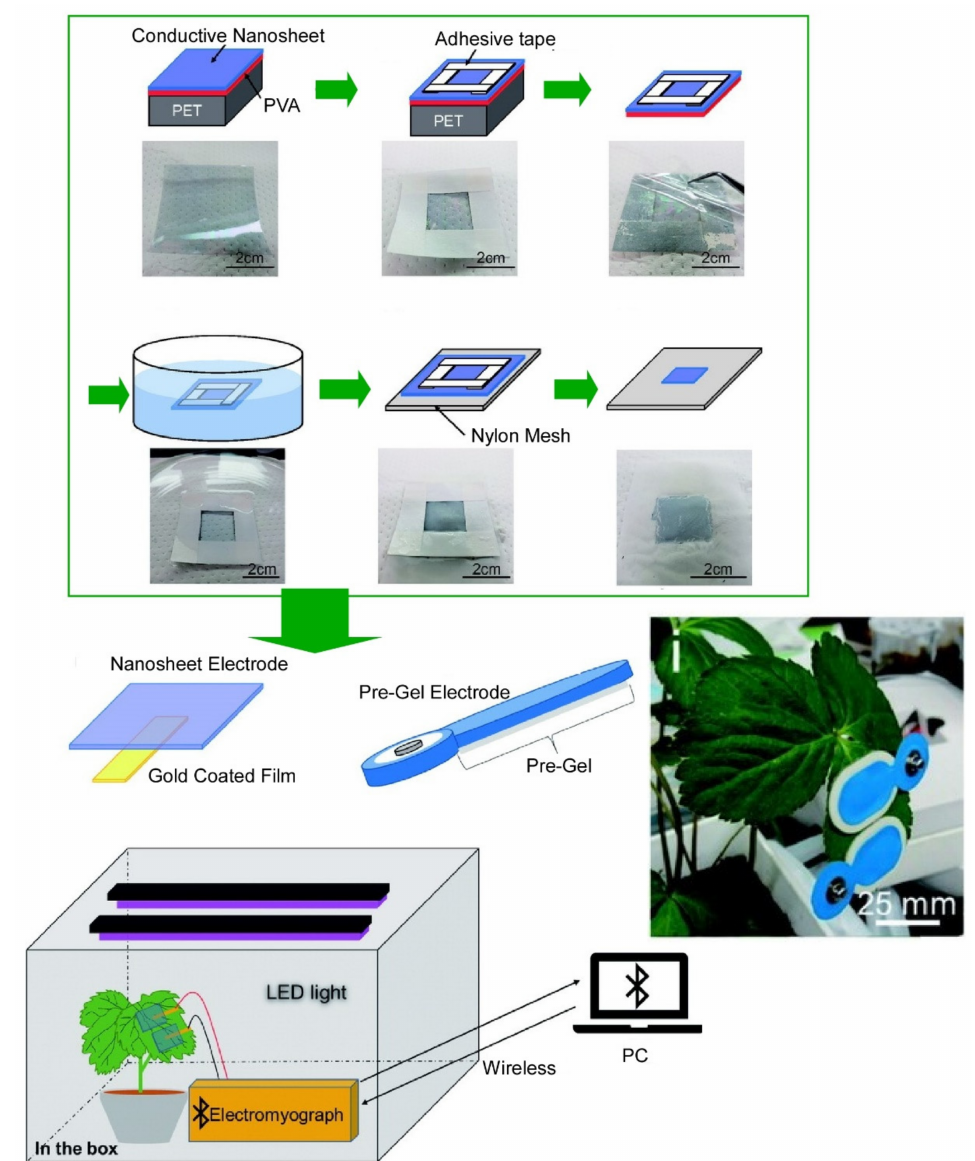
Figure 6. Conductive nanosheets used as bioelectrodes to measure bioelectrical potential of plant leaves wirelessly for up to approximately 1500 h. Reprinted with permission from Reference